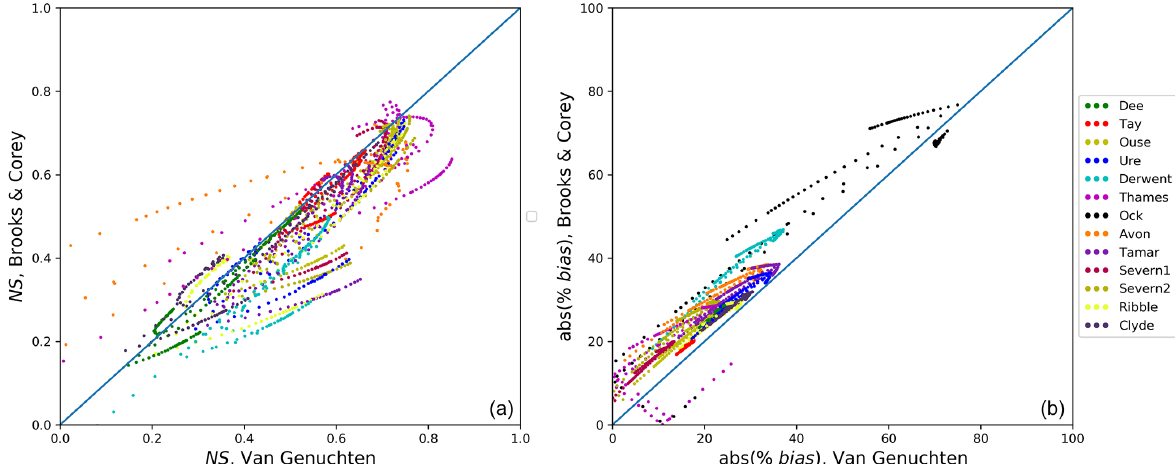
Figure 3. River flow performance metrics (NS in a and absolute value of mean bias in b ) for all tests conducted and for all 13 catchments (colour code in legend). For any given parameter variability test (single dots), metrics obtained using the BC approach for soil hydraulics formulation are indicated on the y axis and metrics using the VG approach are indicated on the x